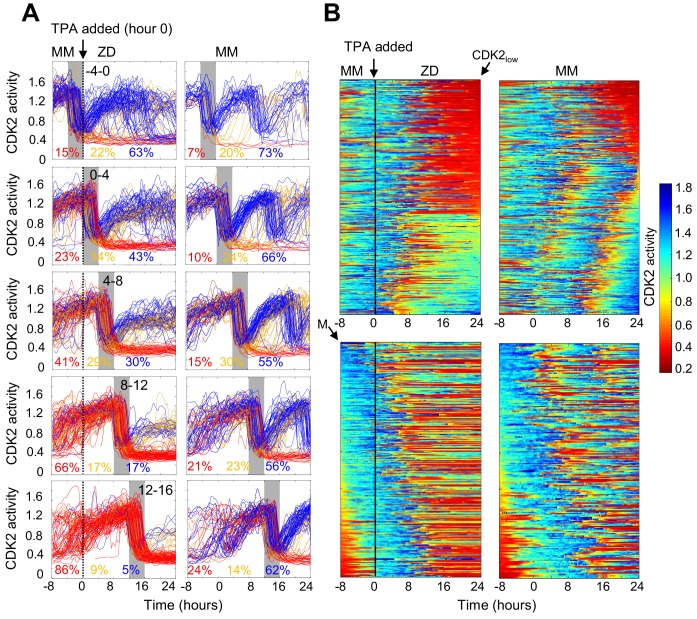
Timing of Zn2+ deprivation with respect to cell cycle phase influences cell fate.(A) Single cell traces of CDK2 ratio over time in cells grown for 8 hr in MM followed by 24 hr in ZD conditions (left panels) or in unperturbed MM (right panels). Arrow/black vertical bar indicates time of TPA addition. Traces are separated by windows of when they underwent mitosis events relative to TPA addition. These 4 hr windows are shaded in gray (−4 to 0 hr relative to TPA addition, 0–4, 4–8, 8–12, and 12–16). Each plot shows n = 120 random traces (except the top right plot: n = 43 due to fewer cells identified in window) from 24 wells for TPA perturbed cells and eight wells for MM cells. The % traces in each category are listed below each plot. Total number of cells analyzed for these calculations: n = 237, 504, 760, 609, and 422 from top to bottom for TPA treatment windows and 43, 124, 165, 185, and 205 from top to bottom for MM windows). Cells are classified and color-coded based on the CDK2 ratio immediately following the first mitosis event. (B) Heatmaps of CDK2 traces from individual cells as grown in A, sorted computationally. Top panel heatmaps are sorted from CDK2low to CDK2high at end of the imaging period. Bottom panel heatmaps are sorted by the time of mitosis (M) at the start of the imaging period. Legend shows the CDK2 color heatmap. n = 321 traces for each heatmap.Figure 3—source data 1.CDK2 ratios as a function of time for each data trace in Figure 3.